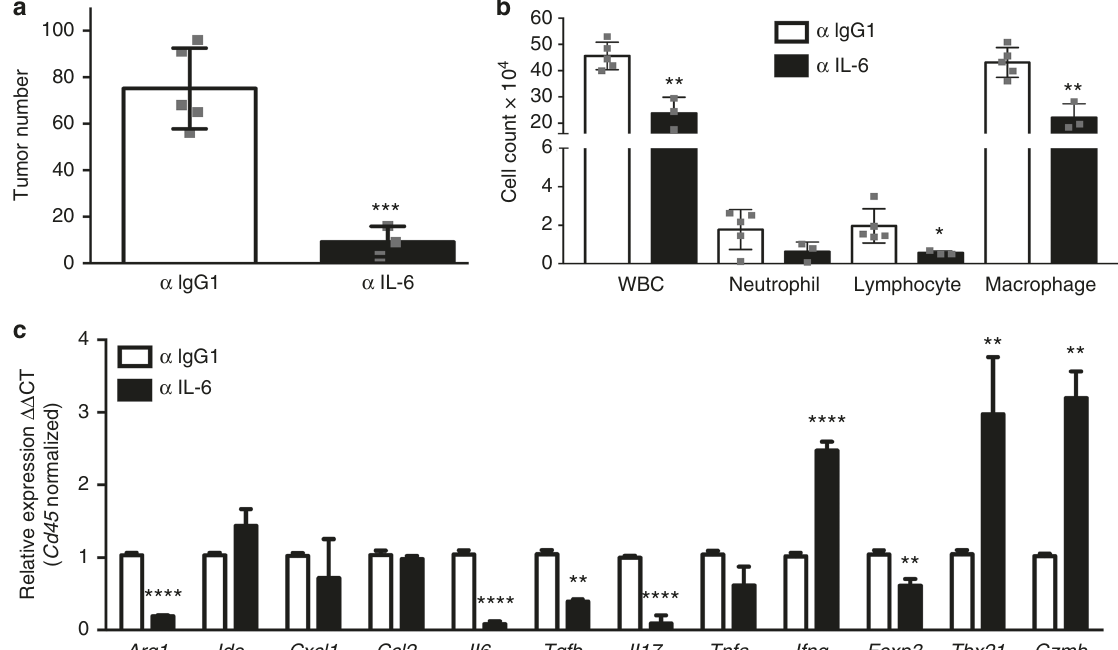
Fig. 5 IL-6 blockade reduces K-ras -induced lung tumorigenesis in male LR/ Stat3 Δ / Δ mice. a Lung surface tumor number in 14-week-old male LR/ Stat3 Δ / Δ mice after treatment with control (IgG1) ( n = 5) or anti-IL-6 ( n = 3) antibody. b Total in fl ammatory cell and lineage-speci fi c leukocyte numbers from BALF of control ( n = 5) or anti-IL-6-treated ( n = 3) male LR/ Stat3 Δ / Δ mice. c Relative expression of Arg1 , Ido , Cxcl1 , Ccl2 , Il6 , Tgfb , Il17 , Tnfa , Ifng , Foxp3 , Tbx21 , and Gzmb mRNA in whole lungs, normalized by CD45 expression, of male LR/ Stat3 Δ / Δ mice after treatment with control ( n = 5) or anti-IL-6 ( n = 3) antibody (data represent means± SEM; ** P < 0.005, * P < 0.05 using two-tailed t -test, experimental replicate # 2 –